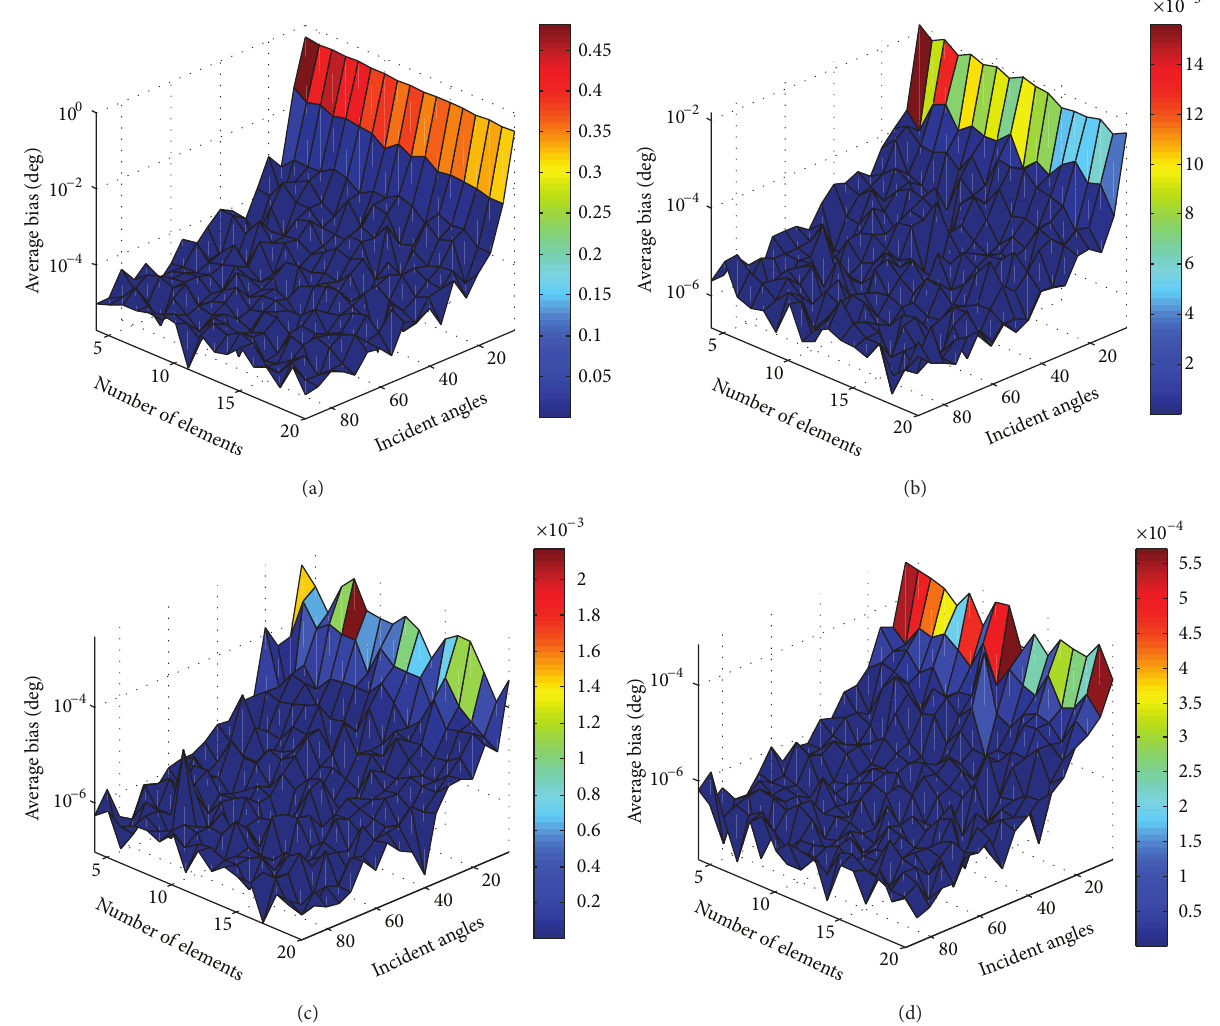
Figure 4: Summary of DOA estimations using MPM for a four-element ULA with the number of array elements varying from 4 to 20. Two equal-power incoming signals are from the directions of 𝜙 1 = 10 ∘ to 90 ∘ and 𝜙 2 = 𝜙 1 + 1 ∘ with an SNR of 5dB. The step size of Δ𝜙 1 = 5 ∘ is considered. The figures show the average biases of the estimated direction. The apertures of the arrays are (a) 0.25𝜆 , (b) 0.5𝜆 , (c) 0.75𝜆 , and (d) 1𝜆